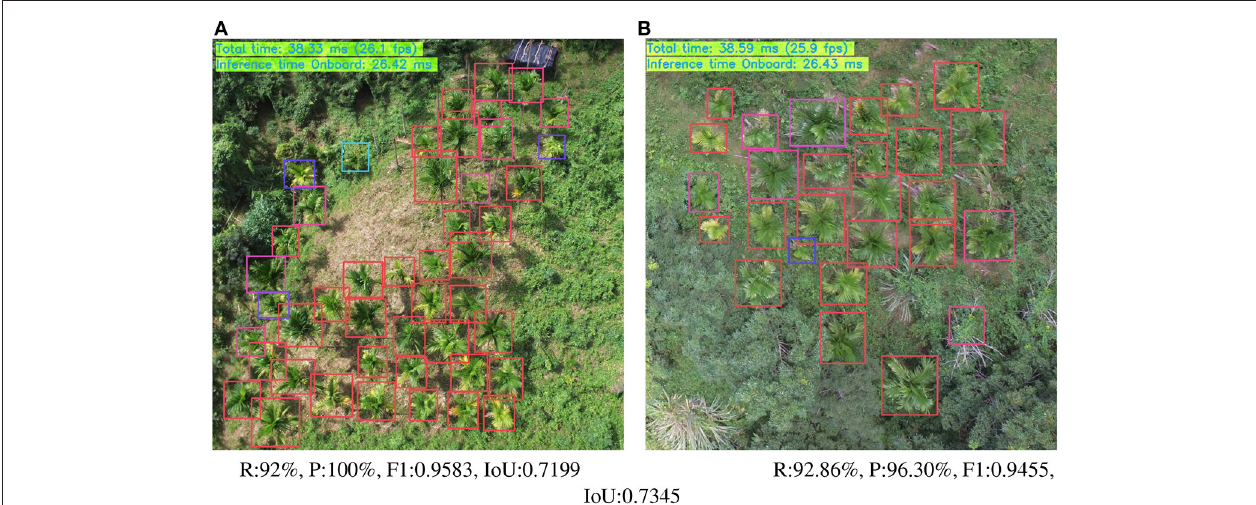
FIGURE 12 | Ag-YOLO run on NCS2 (Input dimension: 416 × 416). Images were taken by a UAV, different colors of the predicted square imply different confidence values, blue is low, and red is high. (A) R:92%, P:100%, F1:0.9583, IoU:0.7199. (B) R:92.86%, P:96.30%, F1:0.9455, IoU:0.7345.